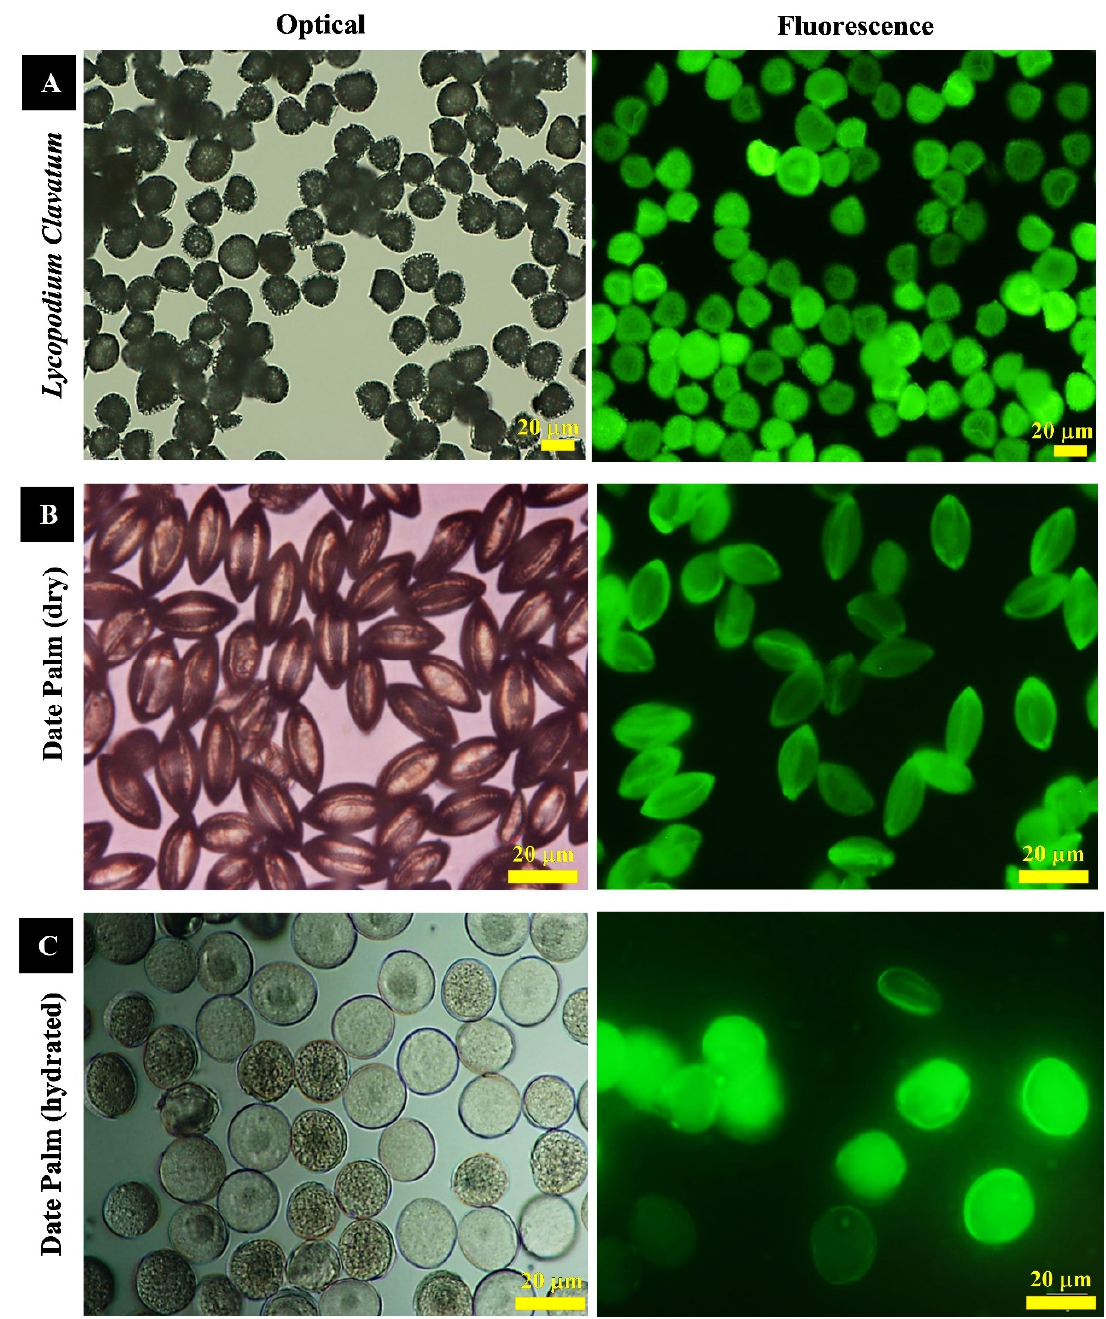
Figure 1. Optical and fluorescent images of raw Lycopodium clavatum and date palm pollens. ( A ) raw Lycopodium clavatum pollens, ( B ) dry date palm pollens, and ( C ) hydrated date palm pollens.